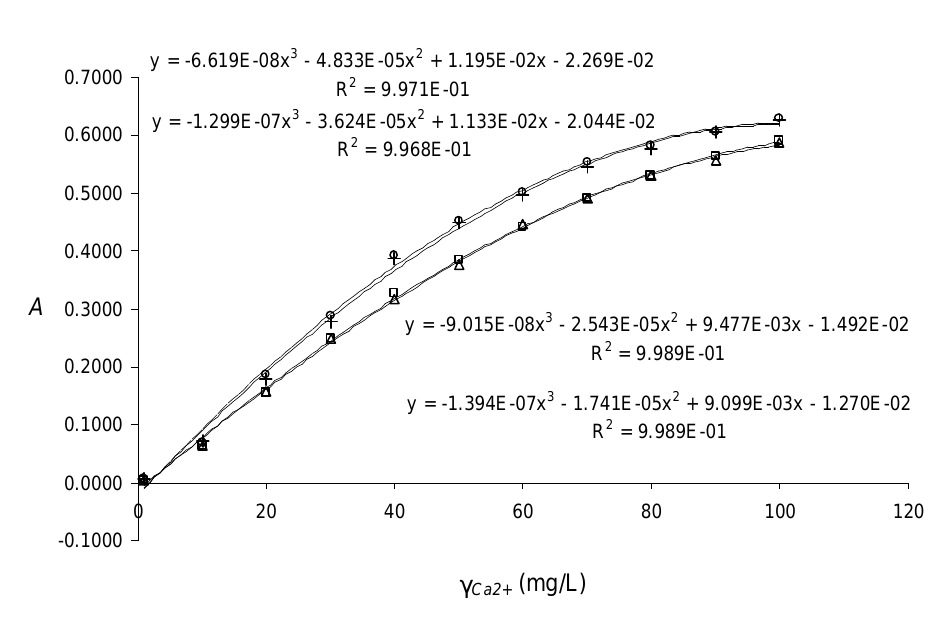
Figure 10. Calibration graphs for calcium ions obtained for two repeated sets of measurements in the FIA system with the T-7xd7 coil or T-7xd16